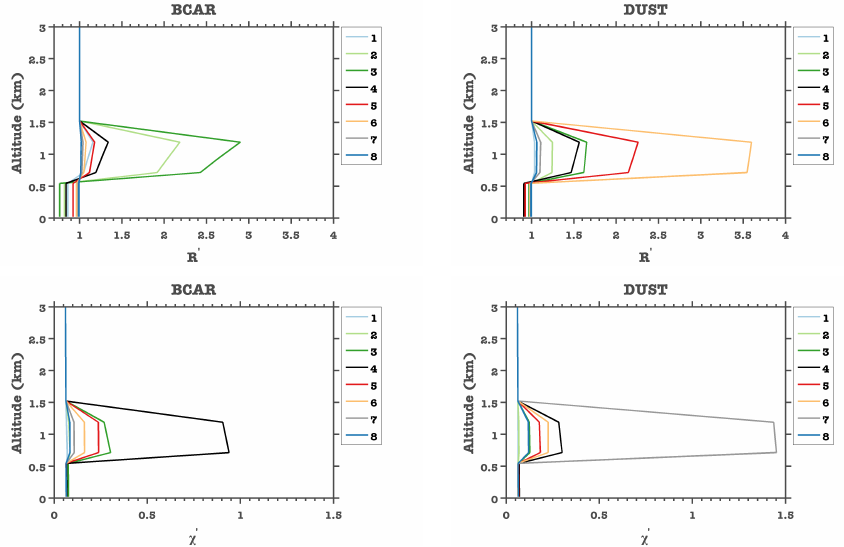
Fig. 5. Profiles of attenuated scattering ratio ( R 0 ) and color ratio ( χ 0 ) for BCAR (left) and DUST (right) per size section as a function of altitude.